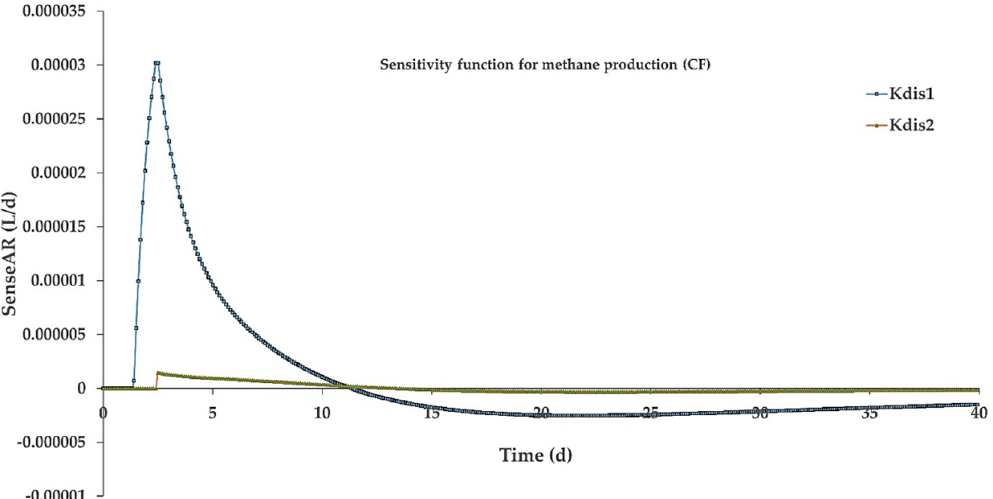
dis1 and K dis2 (RF).